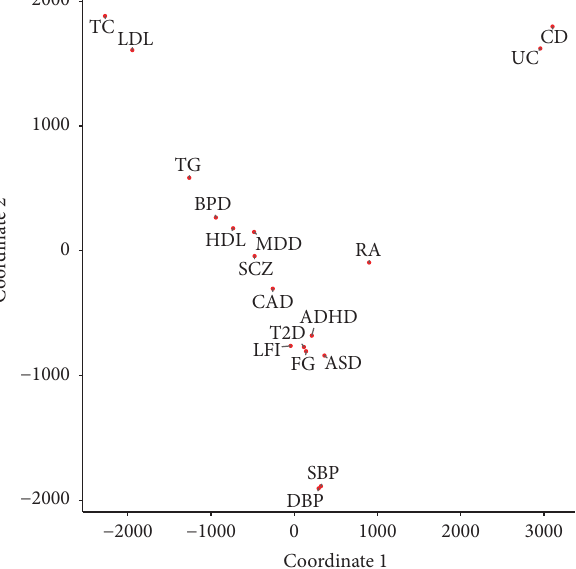
Figure 6: MDS plot for a joint analysis of genetic studies for 18 phenotypes, based on the number of risk SNPs shared between two phenotypes. Here, “risk SNPs” were determined using the GPA algorithm by controlling the global FDR at